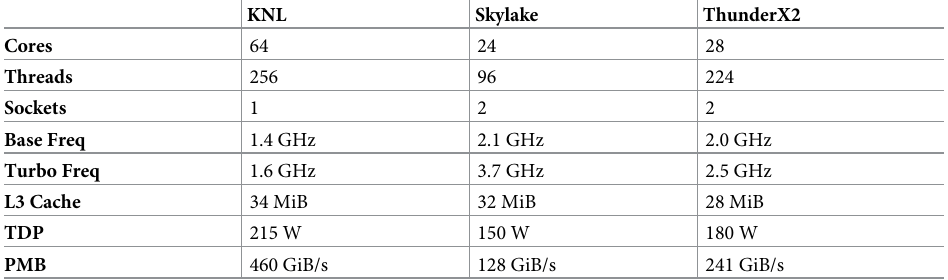
Table 1. Comparison of platform specifications. TDP stands for Thermal Design Power and PMB for the Peak Mem- ory bandwidth. Both values are given per socket.